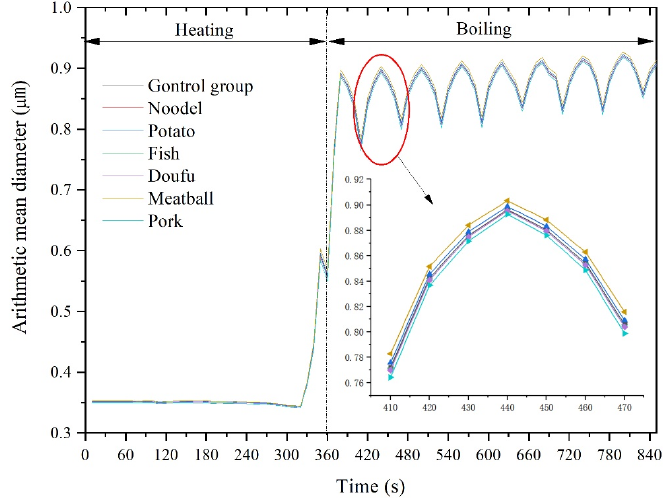
Figure 6. Variation of particle arithmetic mean diameter during boiling.